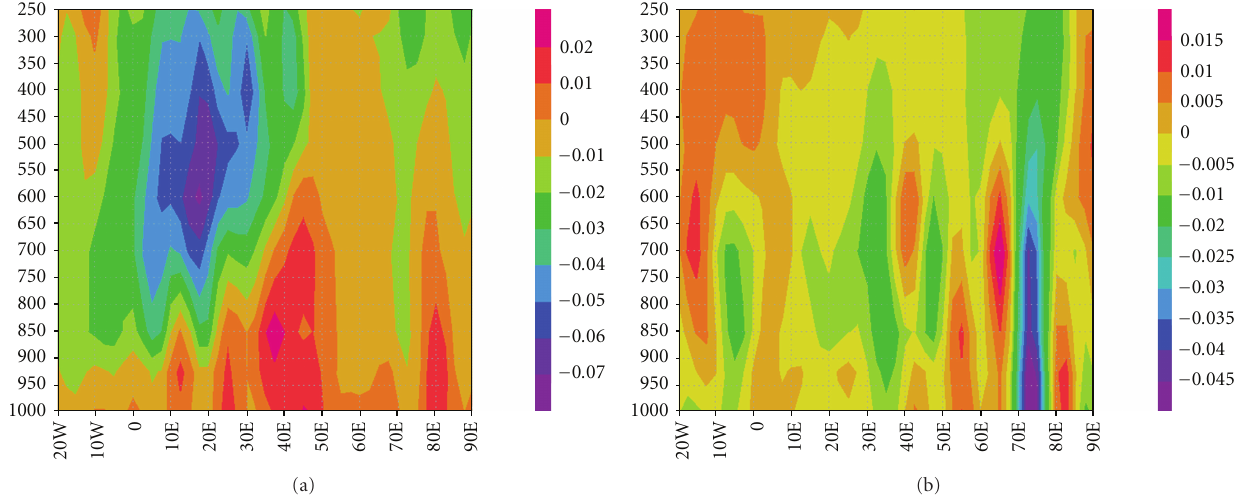
Figure 6: (a) Vertical cross-section di ff erences for ω -composites in Pas − 1 averaged over the latitude band of 10 ◦ N-20 ◦ N. Average over 10 years with SAL lowest pressure minus average over 10 years with SAL highest pressure. (b) Vertical cross section di ff erences for ω -composites in Pas − 1 averaged over the latitude band of 20 ◦ N–35 ◦ N. Average over 10 years with SAL lowest pressure minus average over 10 years with SAL highest